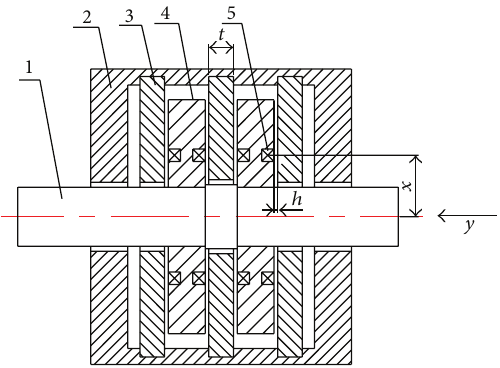
Figure 1: The photograph of MR damping turning tool.